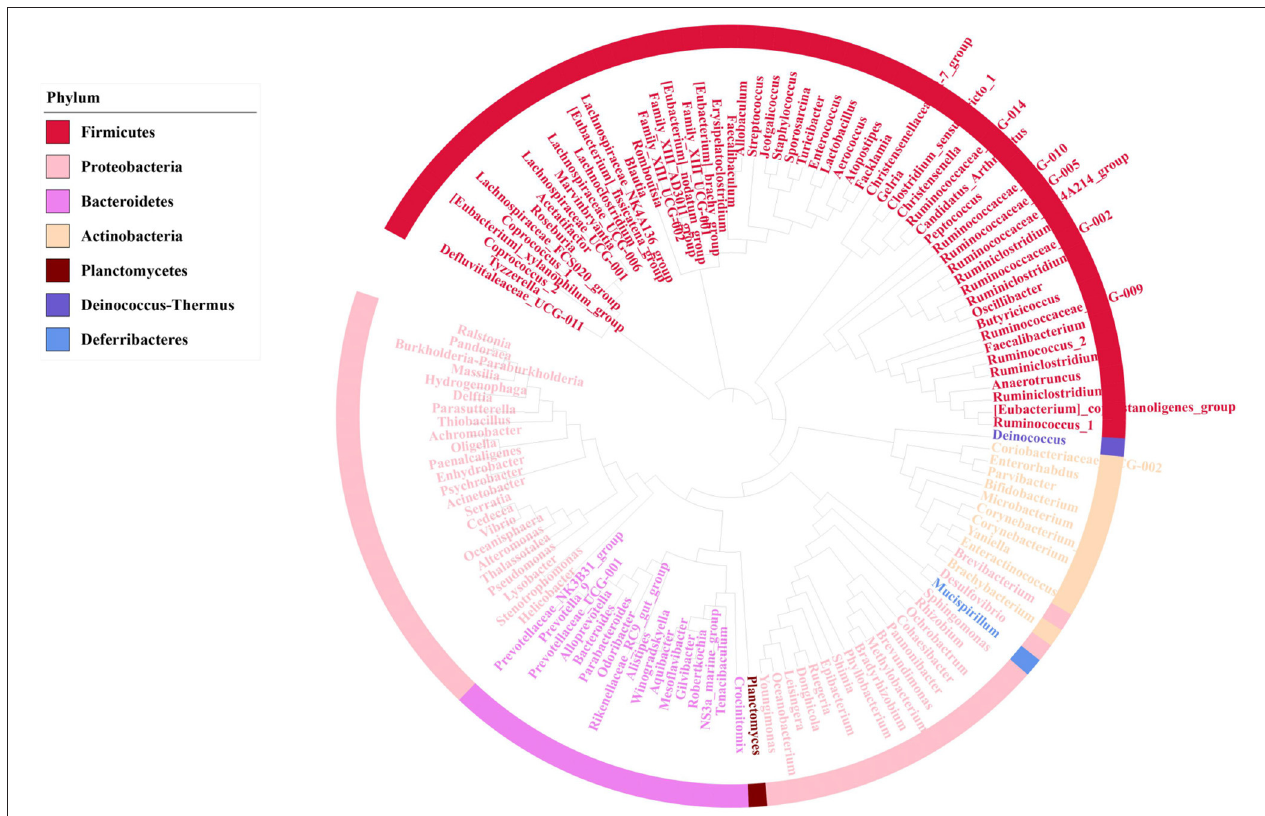
FIGURE 4 | Phylogenetic tree analysis showing top 129 bacterial taxa based on 16S rRNA gene V4-V5 hypervariable regions, after removing 21 features which were uncultured or no rank in genus level. The innermost clades and labels were colored by